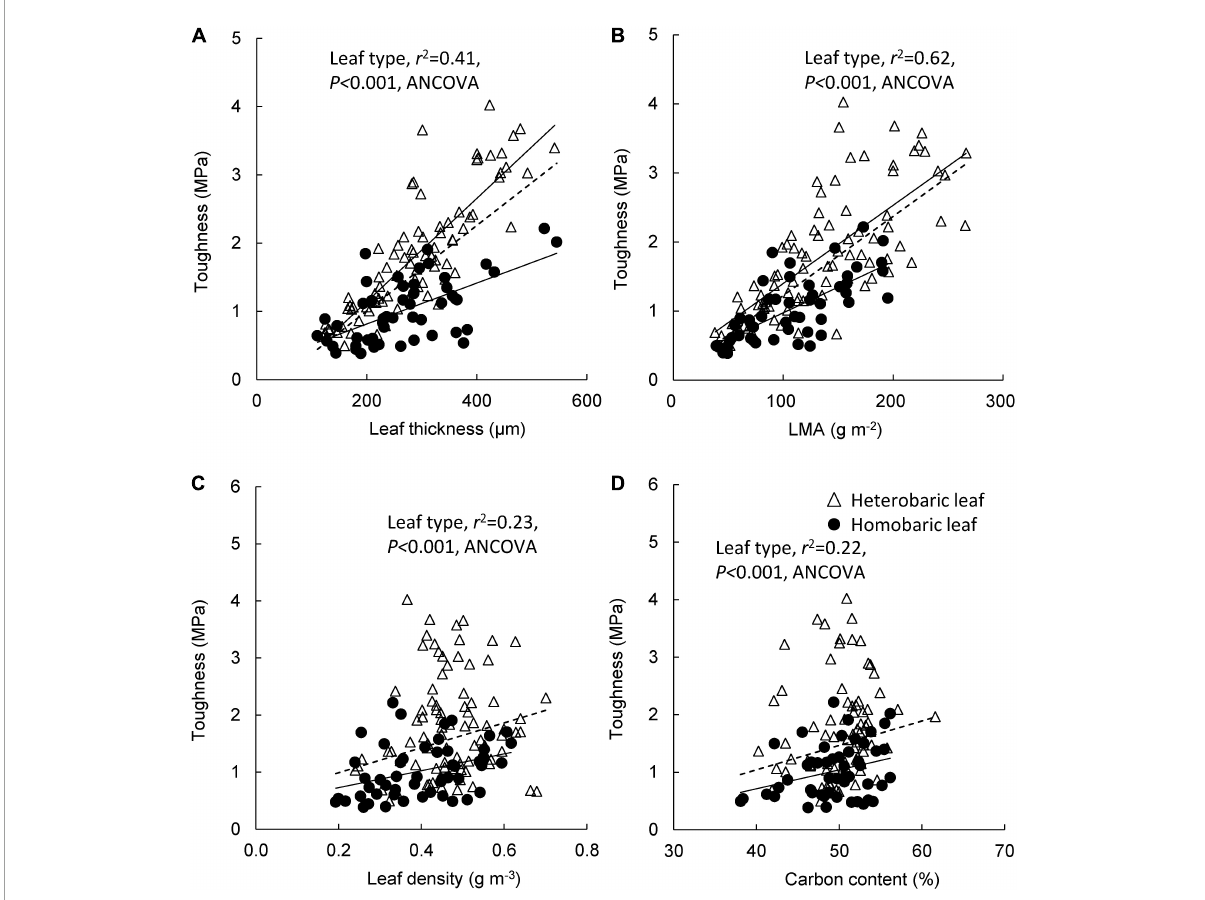
FIGURE4 Leaf toughness in relation to leaf blade thickness (A) , LMA (B) , leaf density (C) , and leaf carbon content (D) . Regression lines are as follows: (A) heterobaric leaf, r 2 = 0.72, P < 0.0001; homobaric leaf, r 2 = 0.37, P < 0.0001; (B) heterobaric leaf, r 2 = 0.53, P < 0.0001; homobaric leaf, r 2 = 0.50, P < 0.0001; (C) heterobaric leaf, ns; homobaric leaf, r 2 = 0.13, P < 0.01; (D) heterobaric leaf, ns; homobaric leaf, r 2 = 0.09, P < 0.05. Details of the results of ANCOVA appear in Appendix 8. “ns” means not significant. Dotted line means regression line for pooled data for both leaf